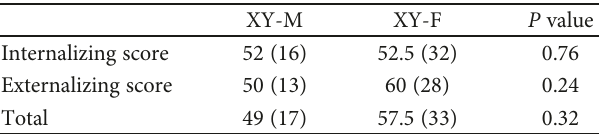
Table 6: Total, internalizing, and externalizing T scores from the CBCL in patients with XY-M and XY-F.